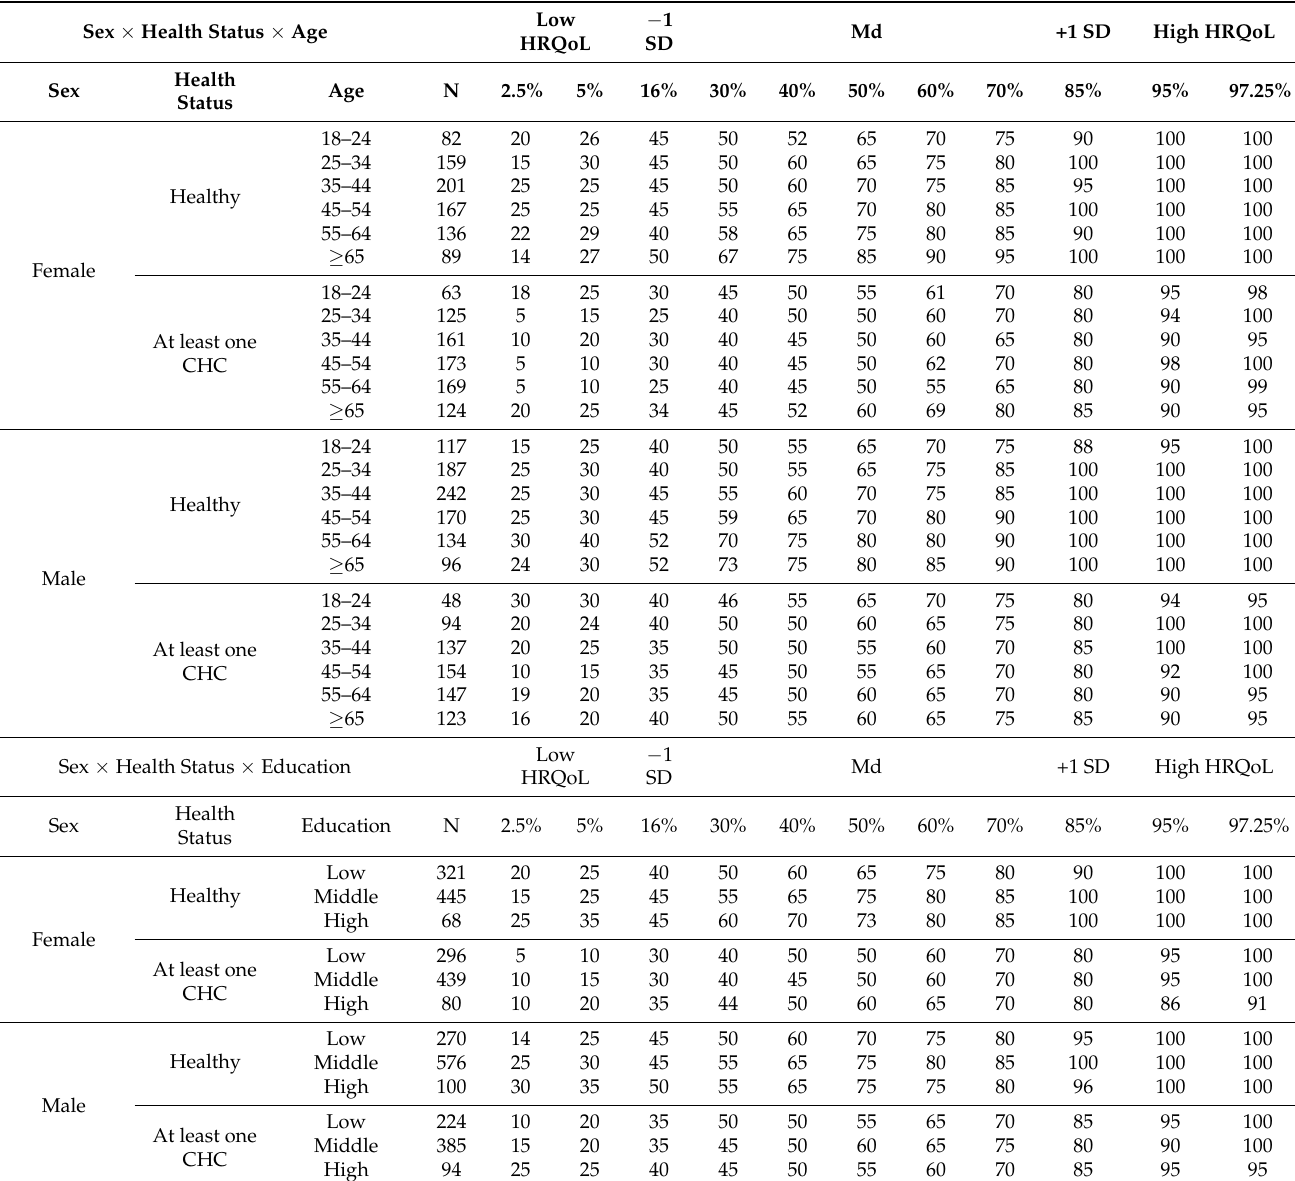
Table A9. Reference values for the QOLIBRI Physical Problems scale obtained from the general population sample in Italy stratified by sex, health status, age, and